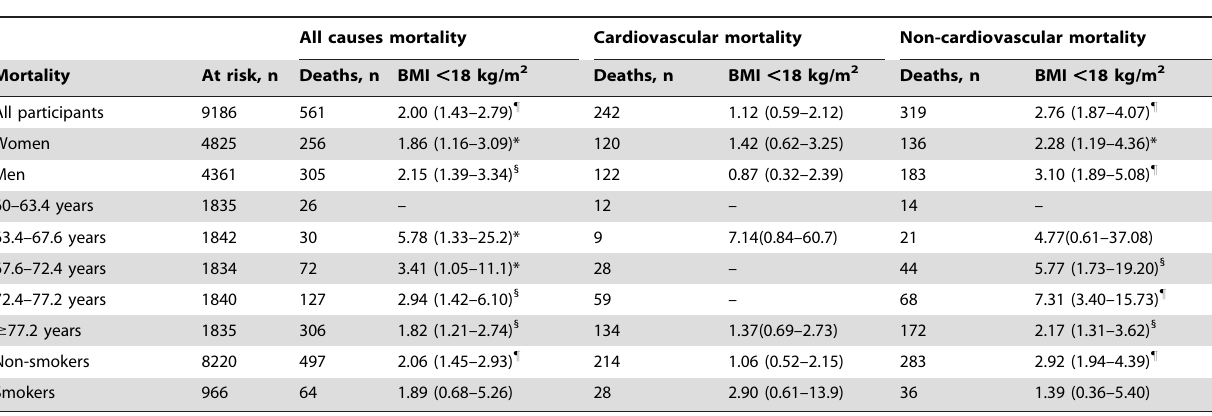
Table 3. Multivariable adjusted hazard ratios for all causes mortality, cardiovascular mortality and non-cardiovascular mortality of body mass index (BMI) , 18 kg/m 2 in subgroup